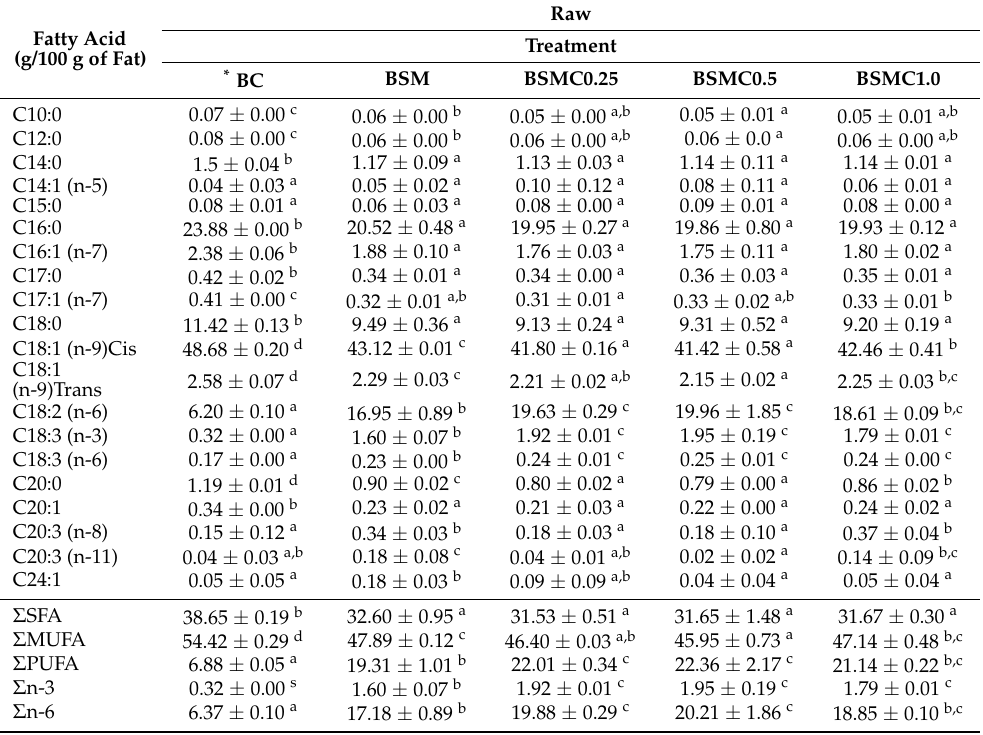
Table 4. Effect of partial replacement of pork backfat with a gelled emulsion of maca flour, soybean oil, and chincho essential oil on the fatty acid profile of raw beef burgers. Fatty Acid (g/100 g of Fat)